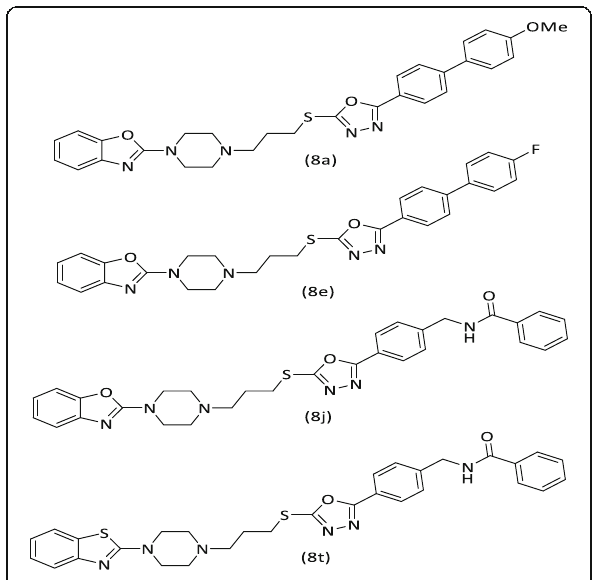
Fig. 2 Benzoxazole-piperazine-1,3,4 oxadiazole